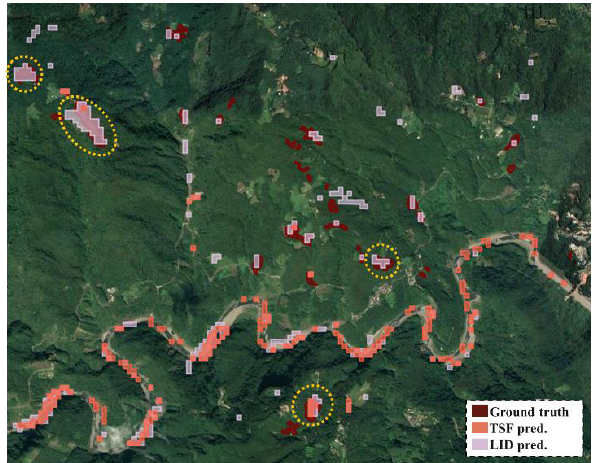
Figure 10. Visualization of classification results (real